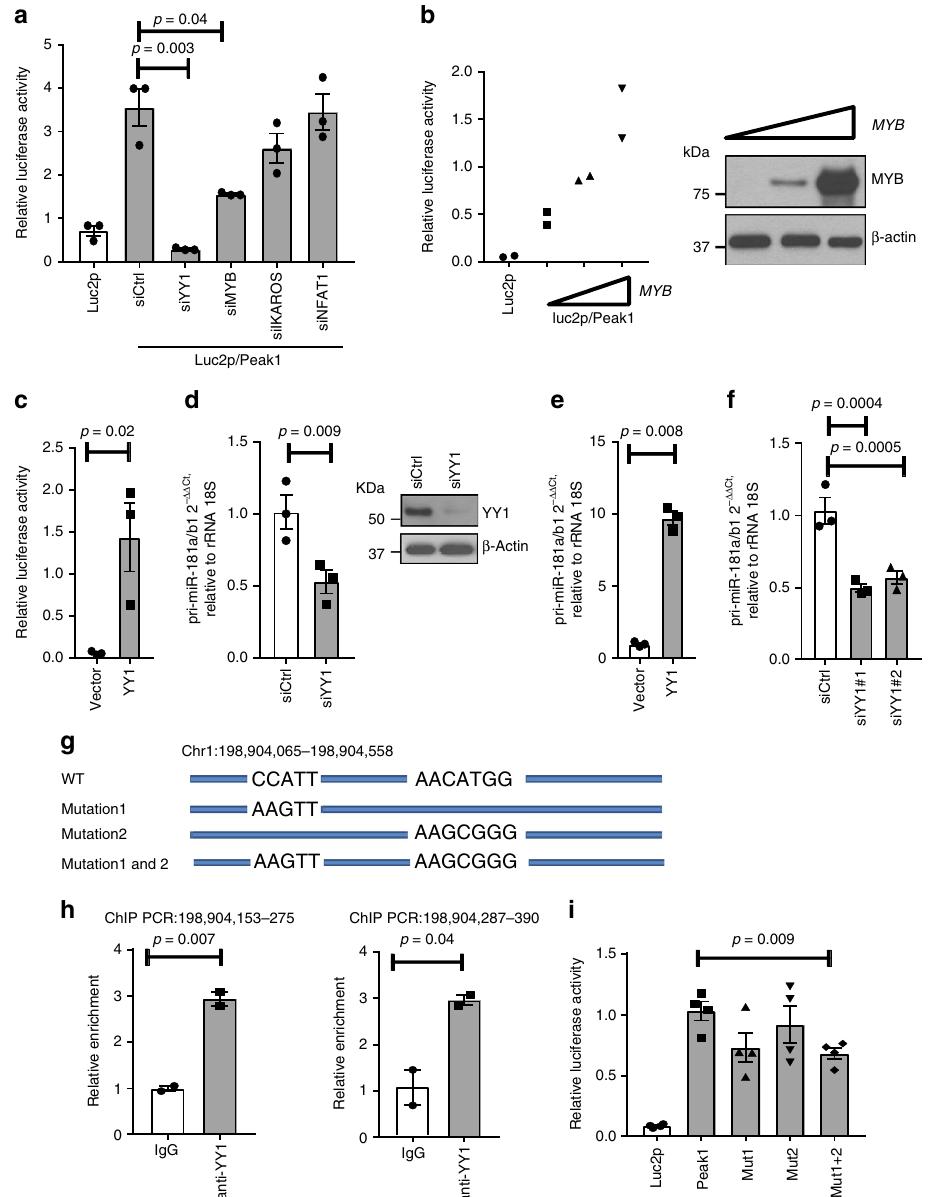
Fig. 2 Transcription factor (TF) networks regulating the pri-miR-181a/b1 enhancer. a siRNAs to TFs with binding motifs in the Peak 1 sequence (YY1, MYB) or to unrelated TFs (IKAROS, NFAT1) were co-transfected with the Luc2p/Peak 1 vector into HEK293T cells. Forty-eight hours later, enhancer activity was tested by the dual luciferase reporter assay. Results are shown as mean ± SEM ( n = 3). b MYB-expressing or empty plasmid were co-transfected with Luc2p/Peak 1 reporter into HEK293T cells. Reporter activities after 48 h are shown as mean ± SEM (left, n = 2). Western blots con fi rmed MYB overexpression (right). c HEK293T cells were transfected with a plasmid expressing YY1 or an empty plasmid together with the Luc2p/Peak 1 reporter. Enhancer activity assessed after 48 h is given as mean ± SEM of triplicates. d siRNA targeting YY1 (YY1 siRNA#1) or control siRNA were transfected into HEK293T cells. pri-miR-181a/b1 transcripts quanti fi ed by qPCR are shown as mean ± SEM of triplicates (left). Western blots in the right panel document knockdown ef fi ciency. e , f Naïve CD4 T cells were transfected with YY1 plasmid ( e ) or YY1 siRNA#1 and siRNA#2 ( f ), and pri-miR-181a was quanti fi ed after 48 h by qPCR. Results are shown as mean ± SEM ( n = 3). g Potential YY1 binding sites at the pri-miR-181a/b1 enhancer region. Wild-type sequences as well as mutated regions used for reporter gene assays in ( i ) are shown. h ChIP assays of Jurkat T cells using anti-YY1 antibodies and primer sets amplifying the indicated two potential binding sites are shown. Results shown are representative of two experiments. i Reporter gene assays using mutated variants of the YY1-binding site as indicated in ( g ). Results are shown as mean ± SEM ( n = 4). Comparisons in a , c , e , h , and i were done by two-tailed unpaired t test, d , f by two-tailed paired t